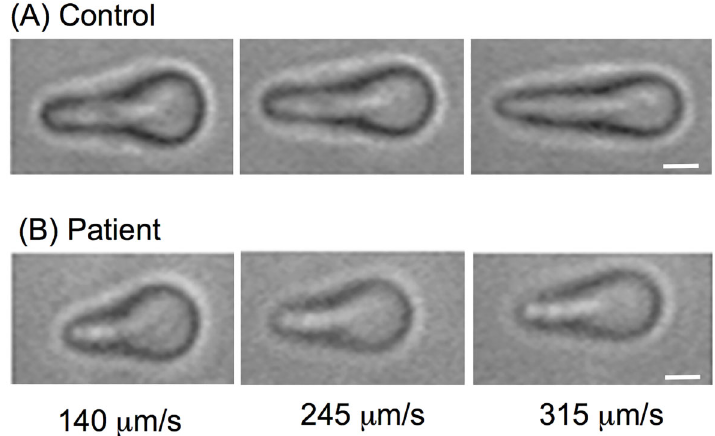
Figure 1. Representative erythrocyte elongations from controls ( A ) and patients with leptospirosis ( B ) obtained in experiments with optical tweezers. The dragging velocities used were 140, 245, and 315 m m/s. Scale bar: 2 m m.